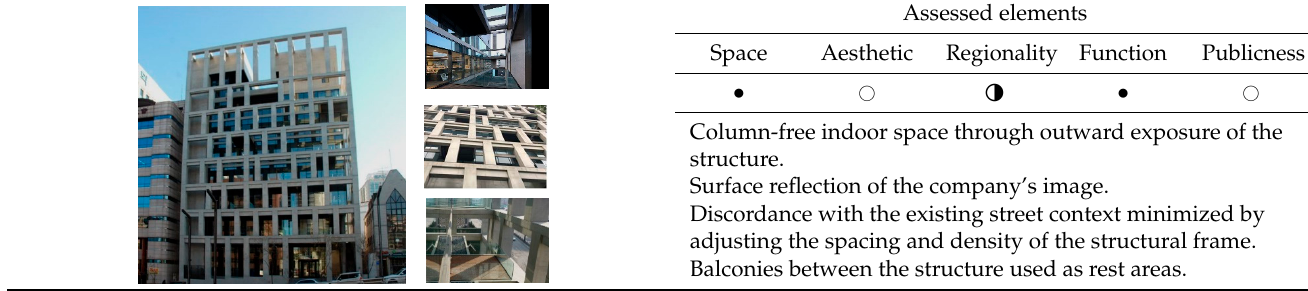
Table 2. Structural facades: KHVatec office building (THE_SYSTEM LAB 2010). Key: Excellent • , Good